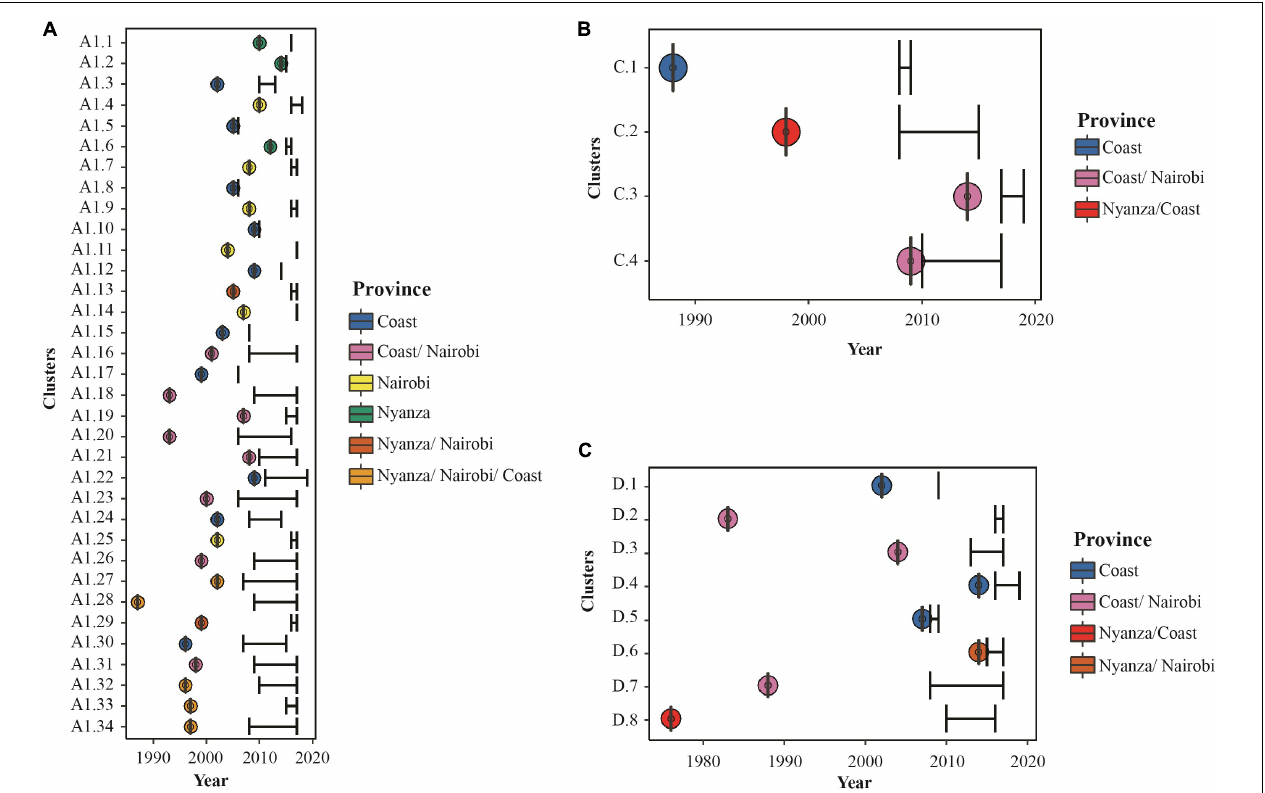
FIGURE 4 | Characteristics and posterior distribution of time to most recent common ancestors estimated for all Kenya clusters. Bayesian tMRCA estimates for (A) HIV-1 sub-subtype A1, (B) HIV-1 subtype C, and (C) HIV-1 subtype D lineages in Kenyan MSM HIV-1 clusters. Dots represent the estimated tMRCA and are colored as per the provinces represented by sequences in each cluster as shown in the legend. Black error bars represent sampling time (with lower interval representing the oldest sampling time per cluster and upper interval representing the most recent sampling time per cluster).